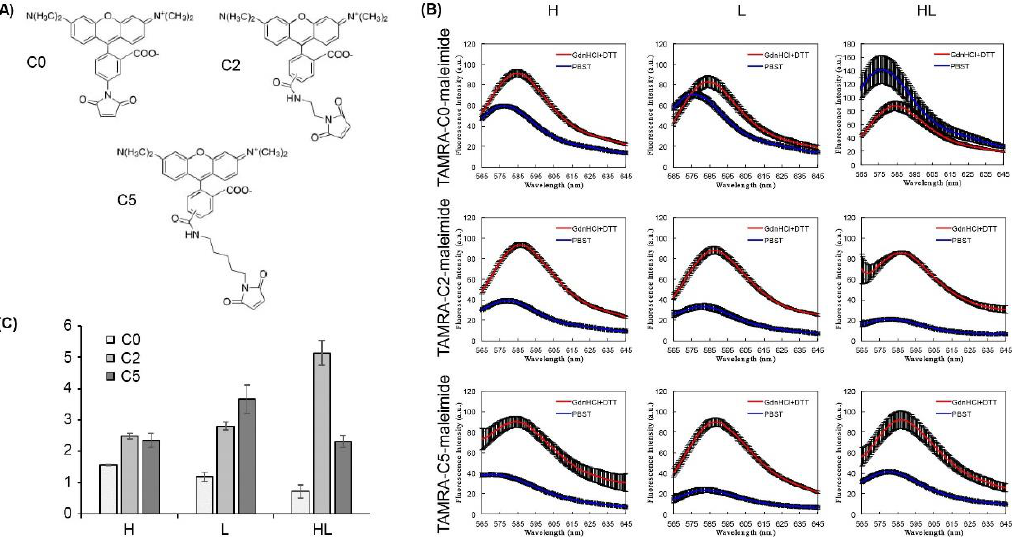
( A ) Chemical structures of TAMRA-C0-maleimide, TAMRA-C2-maleimide, and TAMRA-C5-maleimide; ( B ) fluorescence intensities of Q-bodies in the presence of denaturants (7 M guanidine hydrochloride and 100 mM dithiothreitol) or PBST. Error bars represent ± 1 SD (n = 3); ( C ) normalized fluorescence intensities of each Q-body, which were calculated by dividing the maximum fluorescence intensity in the presence of denaturants by the maximum in the presence of PBST. Error bars represent ± 1 SD (n = 3).